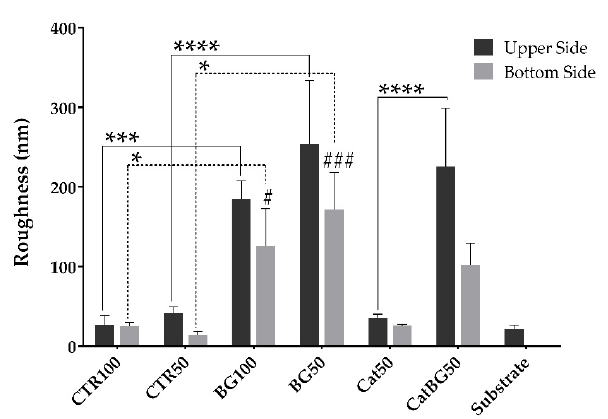
Figure 7. Root mean squared (RMS) roughness of each surface of the produced LbL freestanding films, where the “bottom side” stands for the films’ surface in contact with the substrate during production. Significant differences were found for p < 0.05 (*), p < 0.01 (**), p < 0.001 (***), p < 0.0001 (****), between the same surfaces of each film. Significant differences were found for p < 0.05 (#), p < 0.001 (###) between the corresponding film bottom surfaces and the substrate surface. In straight and dotted line are represented the significant differences between upper surfaces, and between bottom surfaces, respectively.